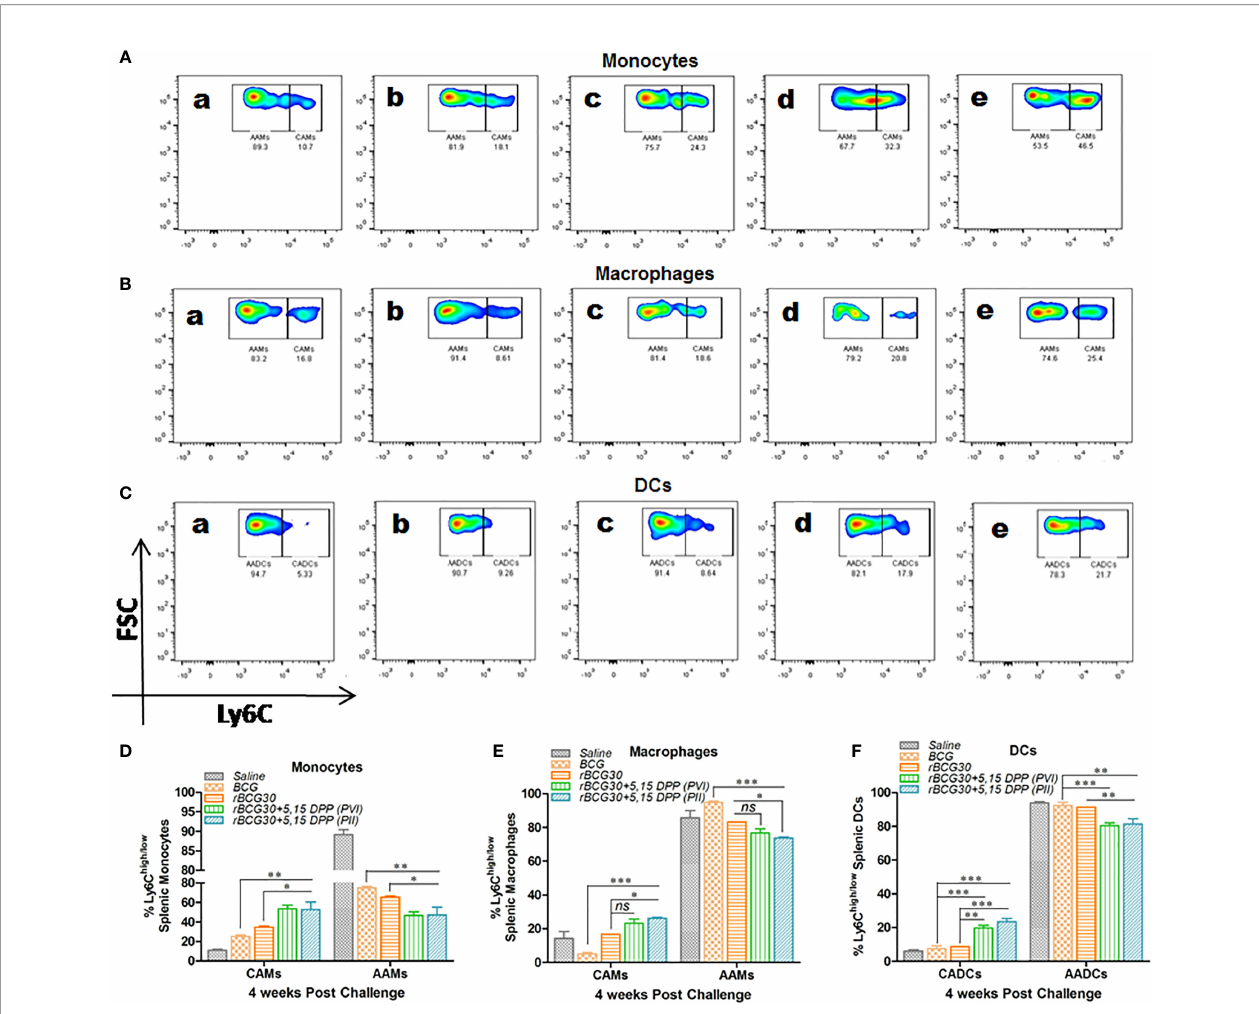
FIGURE 2 | Comparative abundance of the classical and alternative phenotype bearing splenic monocytes/macrophages/DCs at week 4 post-challenge. Representative FACS micrographs (A – C) and corresponding bar graphs (D – F) in the fi gure represent the percent frequency of Ly6C high CAMs/CADCs and Ly6C low AAMs/AADCs among (A, D) CD11b + F4/80 - SSC low monocytes, (B, E) CD11b + F4/80 + SSC low macrophages, and (C, F) CD11b - F4/80 - SSC low DCs isolated from the spleen of mice belonging to various groups and pro fi led using fl ow cytometry. The groups included in the study and depicted in the FACS micrographs were: (a) Saline, (b) BCG, (c) rBCG30, (d) rBCG30+5,15-DPP (PVI), and (e) rBCG30+5,15-DPP (PII). The results depicted in the fi gure are representative of two independent experiments and are presented as means ± SEM of one of the two experiments with similar observations. The signi fi cance testing of differences between various groups was performed employing two-way ANOVA followed by Bonferroni ’ s multiple comparison post-test. The p values, <0.05(*), <0.01(**), <0.001(***) were considered as signi fi cant for analysis and interpretation of data. ns, non-signi fi